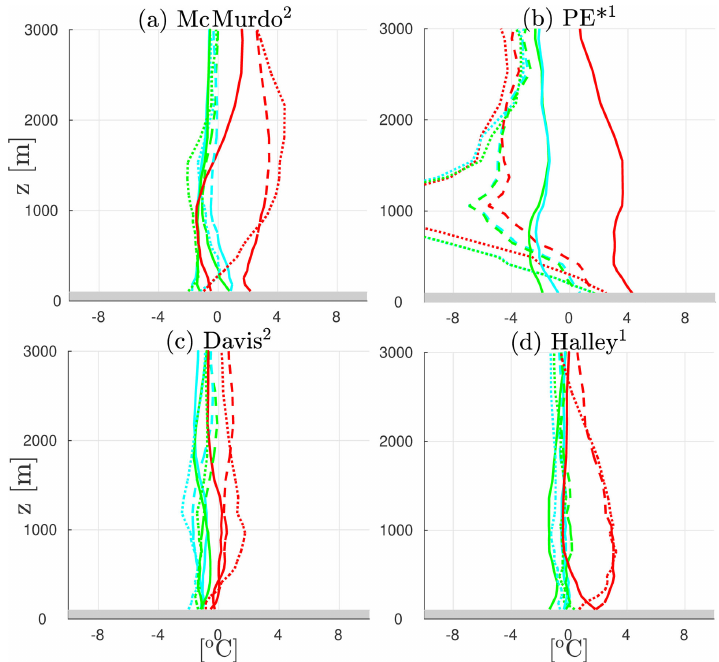
Figure 7. Yearly median differences (solid lines), 80–20th interquartile difference (dashed lines) and 95–5th interquartile difference (dotted lines) with respect to radiosoundings for temperature at four Antarctic stations. Red, green and cyan lines refer to Polar WRF, ERA5 and ERA-I, respectively. Grey strips delimit the first 100m above the ground surface. Polar WRF and ERA reanalyses are conditioned to radiosounding times. Numbers in exponential form next to station names in the title indicate the number of radiosoundings per day at the corresponding station. The “ ∗ ” symbol labels the station for which only DJF data are